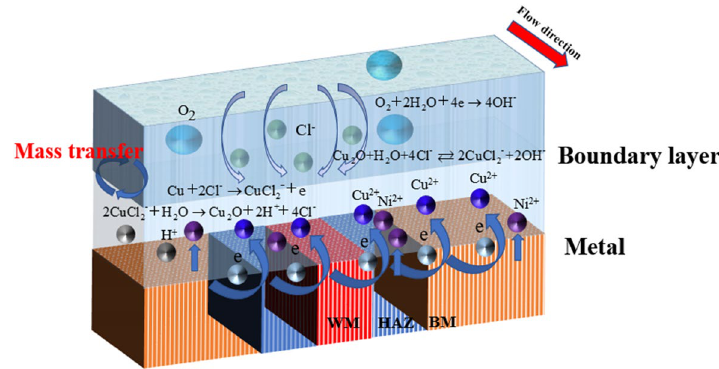
Figure 18. Corrosion reaction process of B10 alloy welded joint in flowing